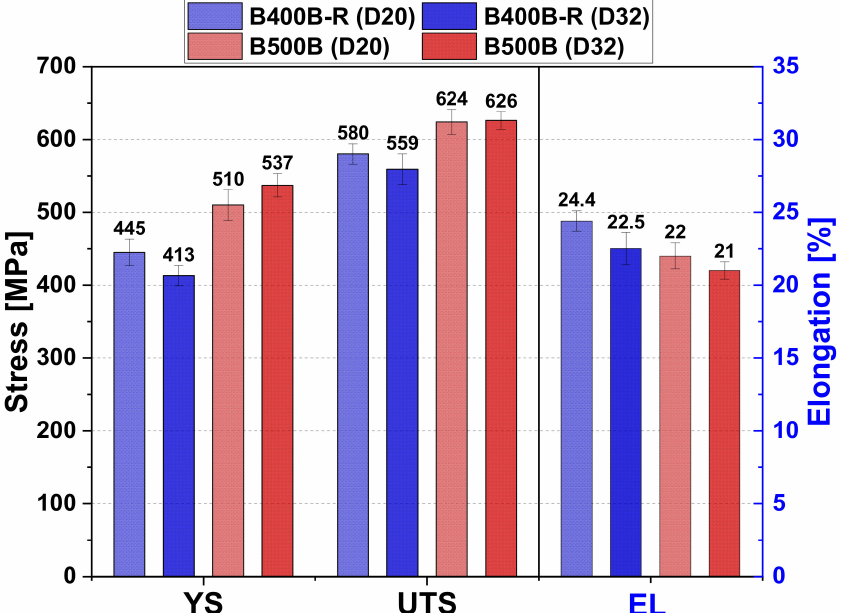
Figure 8. Evaluated tensile properties of B400B-R and B500B steel grades represented in bar chart for D20 and D32 rebars. YS , UTS and El stand for yield strength, ultimate tensile strength and percent of total elongation,